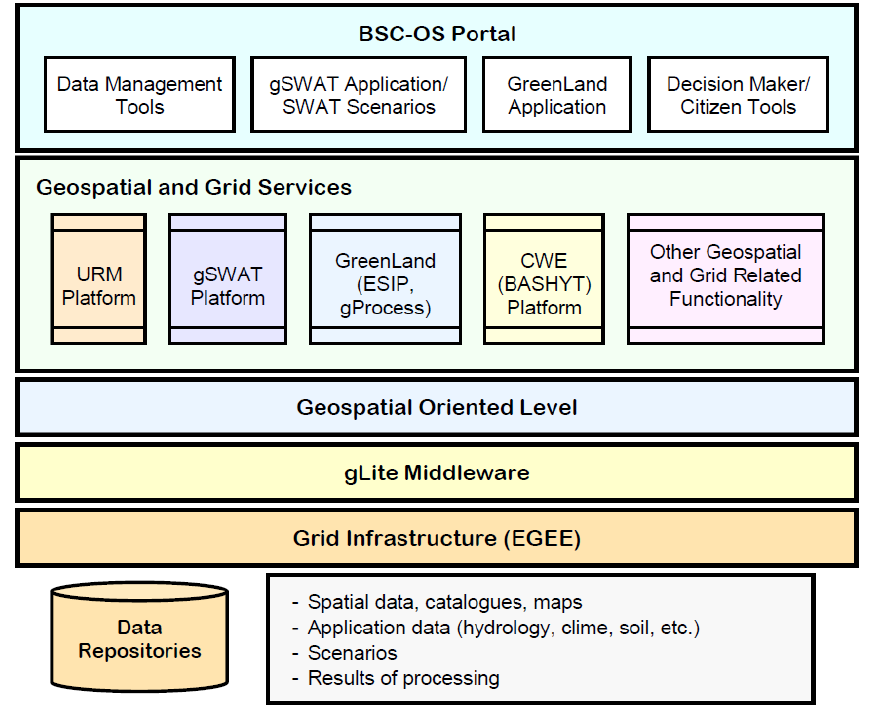
Fig. 1. BSC-OS portal